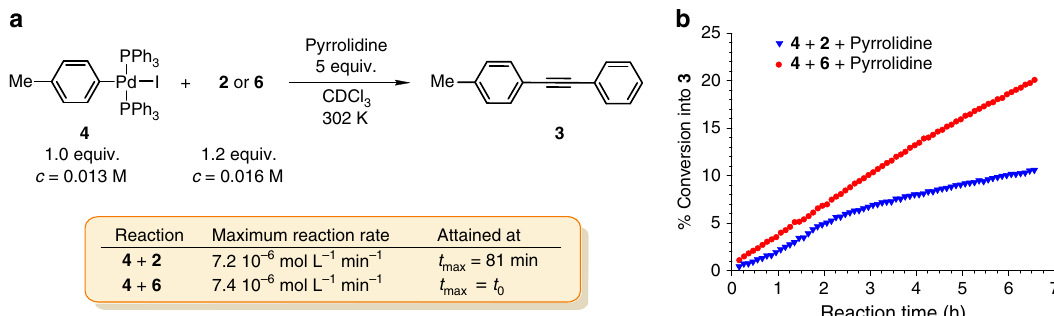
Fig. 5 Putting on trial the mono-metallic mechanism from Fig. 1c. a Independent reaction between authentic 4 and 6 or acetylene 2 in the presence of pyrrolidine. b Tolan 3 build-up (Supplementary Note 3 and Supplementary Figs. 17 – 22)